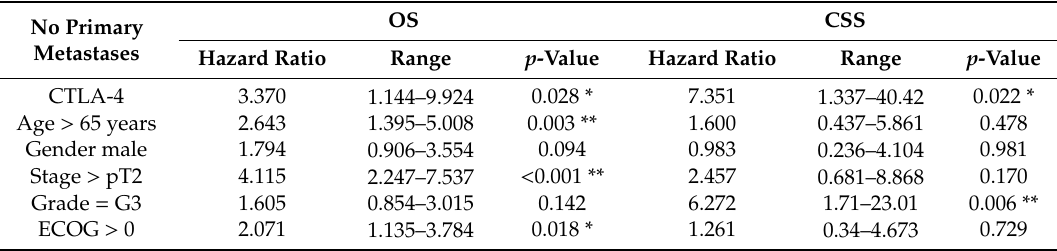
Table 8. Multivariate Cox regression analysis: Association of clinical parameters and CTLA-4 expression with OS or CSS in the no primary metastases